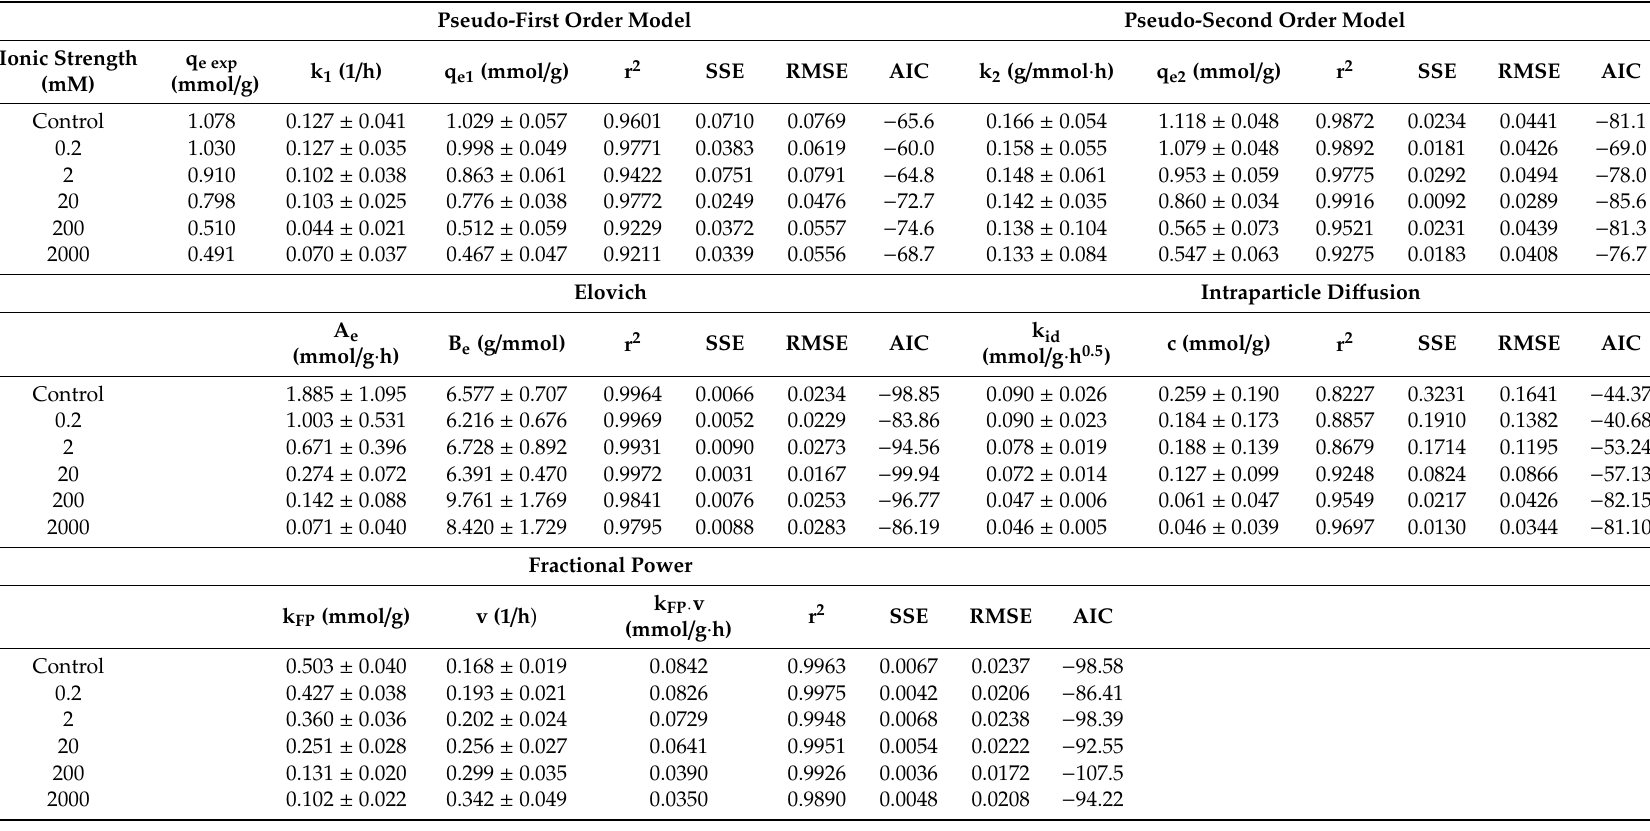
Table 2. E ff ect of the NaCl ionic strength on the parameters of di ff erent kinetic models for the biosorption of Ni 2 + by